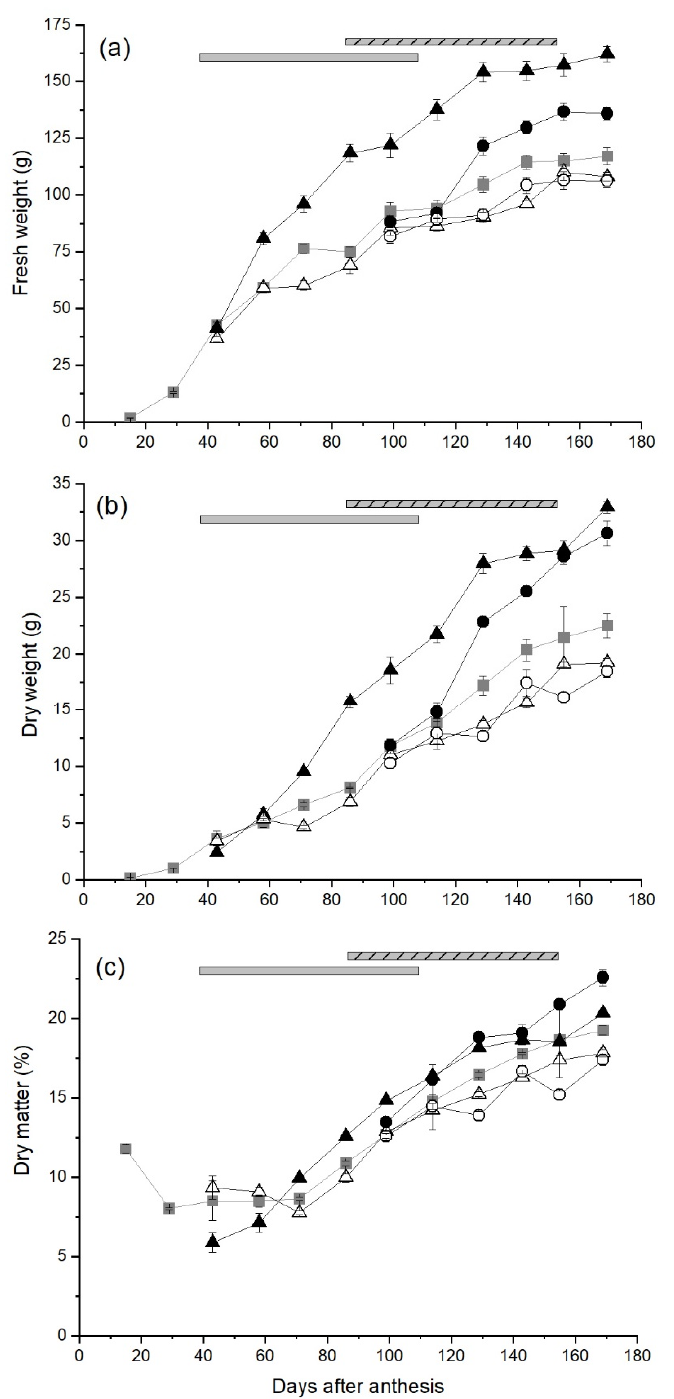
Figure 1. The effect of time of manipulation of carbohydrate supply together with phloem girdling on fruit ( a ) fresh weight ( b ) dry weight and ( c ) dry matter content of Actinidia chinensis var. chinensis ‘Zesy002’. kiwifruit from anthesis through to harvest. Data are shown for ungirdled control canes ( (cid:4) ), early girdled canes with high ( (cid:78) ) or low ( (cid:52) ) carbohydrate supply or late girdled canes with high ( • ) or low ( ) carbohydrate supply. Early treatments were applied at 38 days after anthesis with the duration of the open girdle shown by the grey solid bar at the top of each panel. Late treatments were applied at 86 days after anthesis with the duration of the open girdle shown by the grey/black stripped bar at the top of each panel. High carbohydrate supply treatments had six leaves per fruit, while low carbohydrate supply treatments had one or two leaves per fruit. Data are means ± the standard error of the mean (SEM), n = 5.